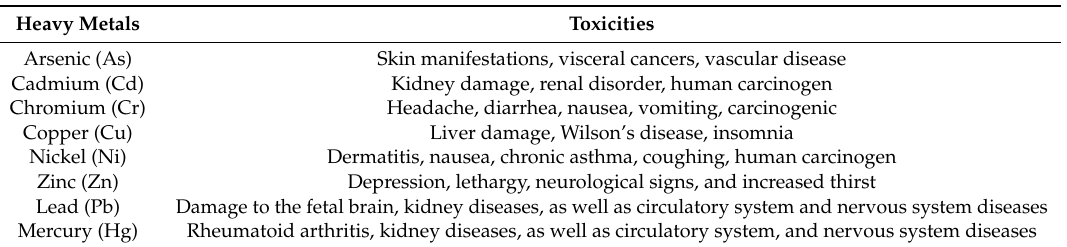
Table 3. List of heavy metal toxicities